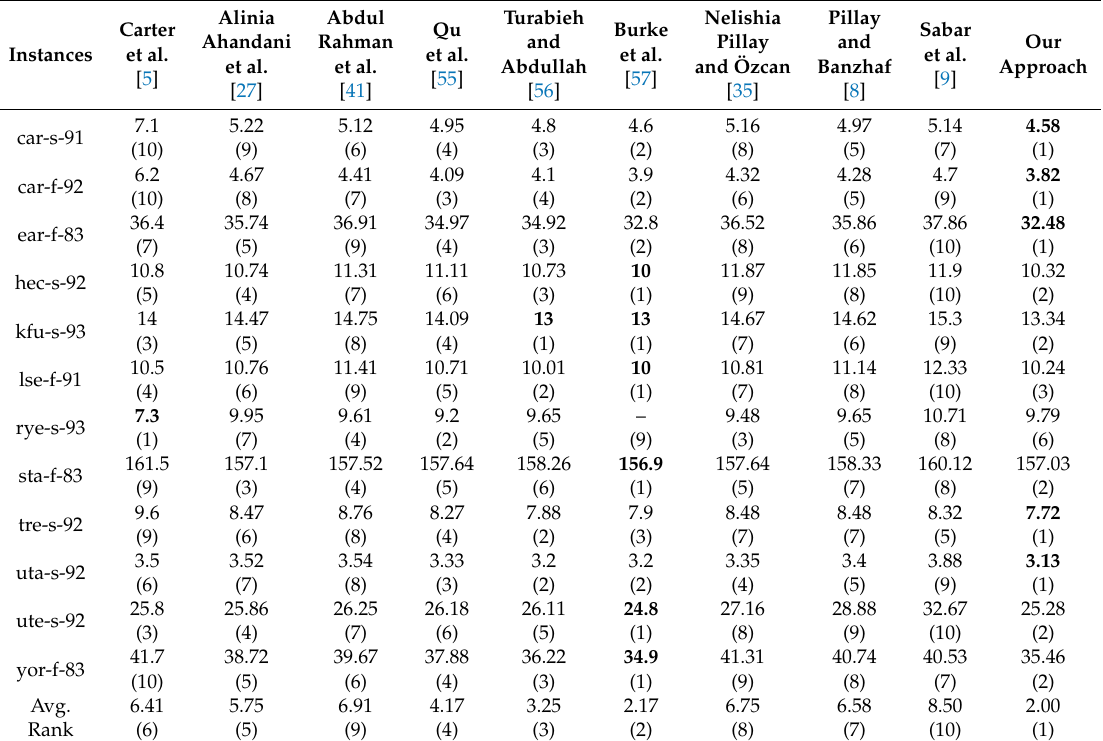
The best results obtained are highlighted in bold. Value in bracket shows the rank of the corresponding penalty